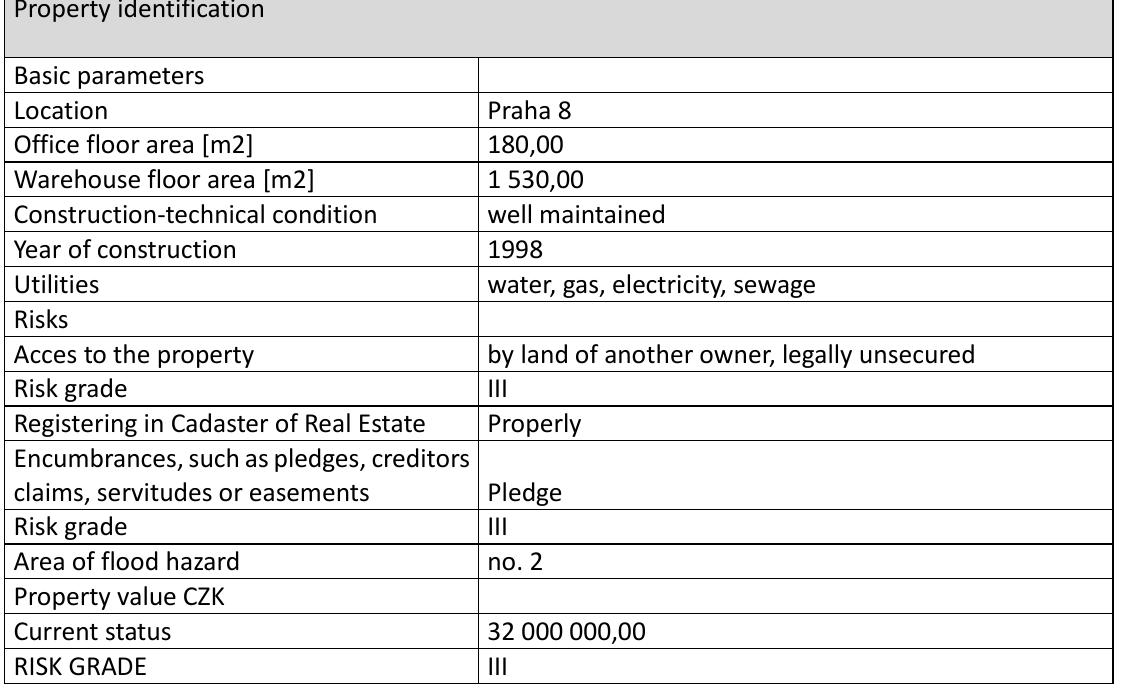
Table 5 - Property No. 2 (own source) Property identification